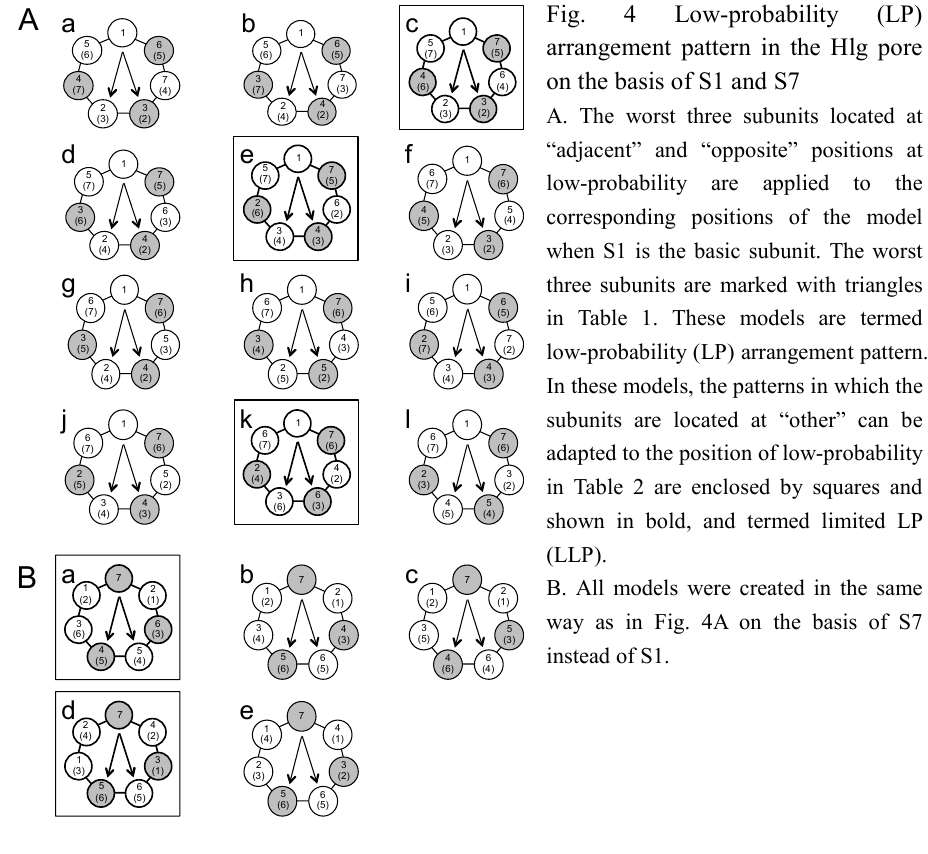
Fig. 4 Low-probability (LP) arrangement pattern in the Hlg pore on the basis of S1 and S7 A. The worst three subunits located at “adjacent” and “opposite” positions at low-probability are applied to the corresponding positions of the model when S1 is the basic subunit. The worst three subunits are marked with triangles in Table 1. These models are termed low-probability (LP) arrangement pattern. In these models, the patterns in which the subunits are located at “other” can be adapted to the position of low-probability in Table 2 are enclosed by squares and shown in bold, and termed limited LP (LLP). B. All models were created in the same way as in Fig. 4A on the basis of S7 instead of